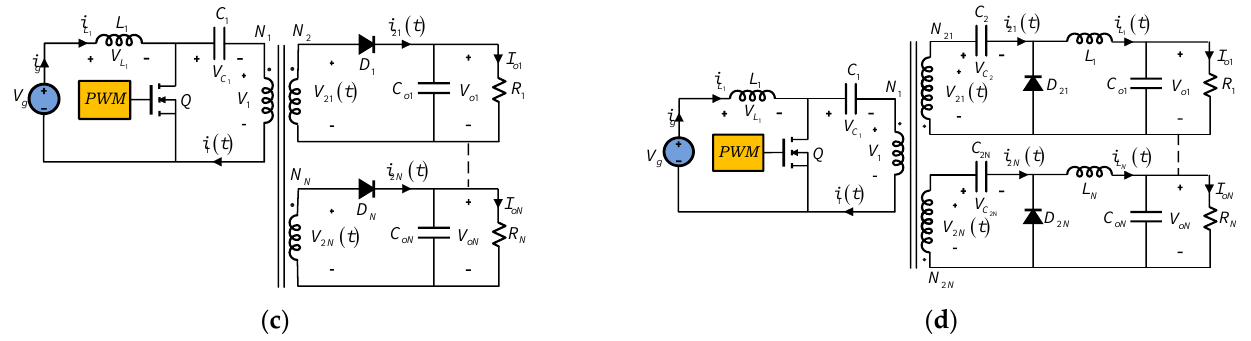
Figure 4. Multiple-Output Isolated DC – DC Converters Topologies. ( a ) Active Clamp Forward Converter. ( b ) Isolated Zeta Converter. ( c ) Isolated SEPIC Converter. ( d ) Isolated Ćuk Converter.